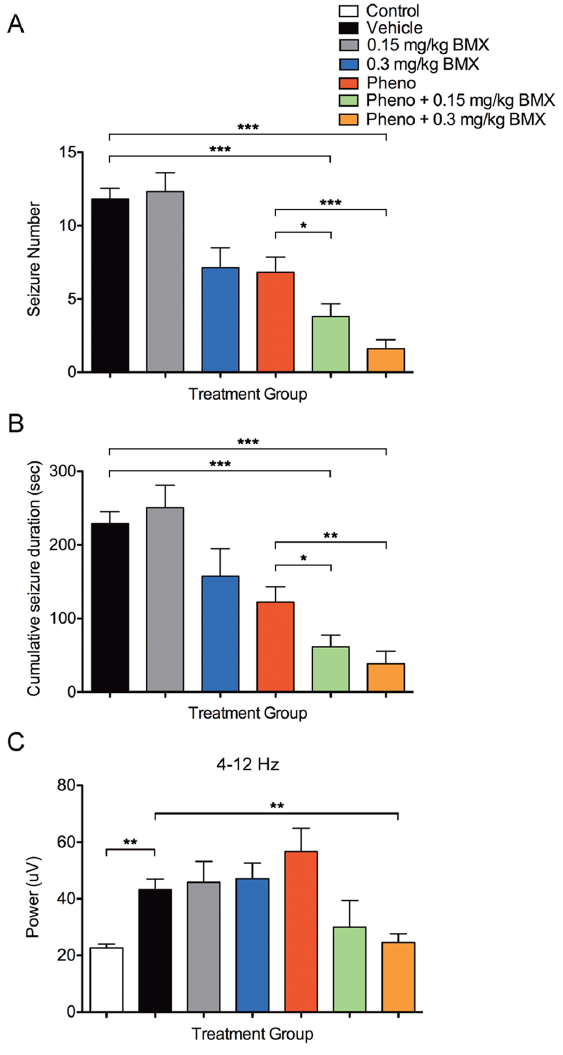
Figure 2. Seizure number, cumulative duration, and EEG power attenuation in rats treated with phenobarbital and bumeta- nide. The number of hypoxia-induced seizures (A), and cumulative seizure duration (B) were plotted for each treatment group. Vehicle- treated rats (n=38) averaged 11.8 6 0.7 seizures, with an average cumulative seizure duration of 229 6 16.3 s. Treatment with